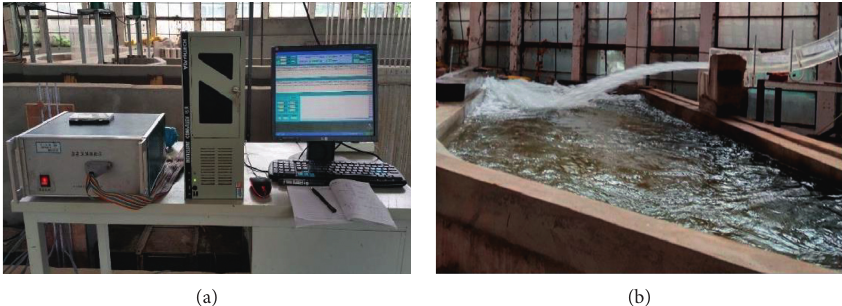
Figure 3: Photos of testing instruments and experimental process. (a) Fluctuating pressure testing instrument. (b) Experimental process.